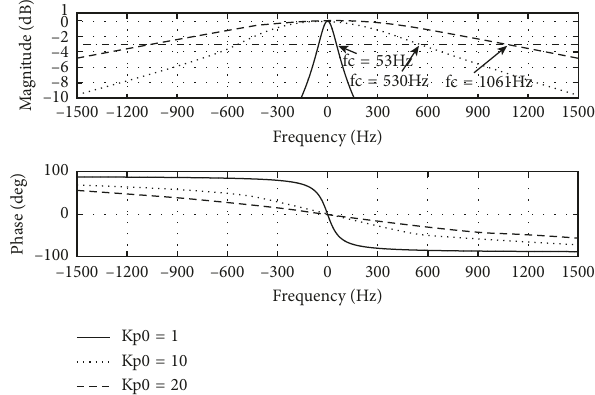
Figure 7: Bode diagram of fundamental close loop control.